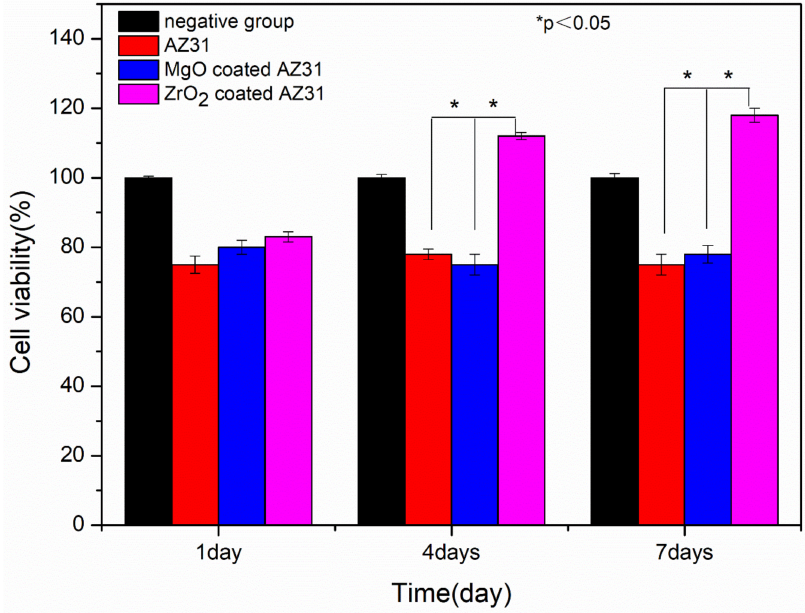
Figure 10. Cell viability of AZ31, MgO-coated AZ31, and ZrO 2 -coated AZ31